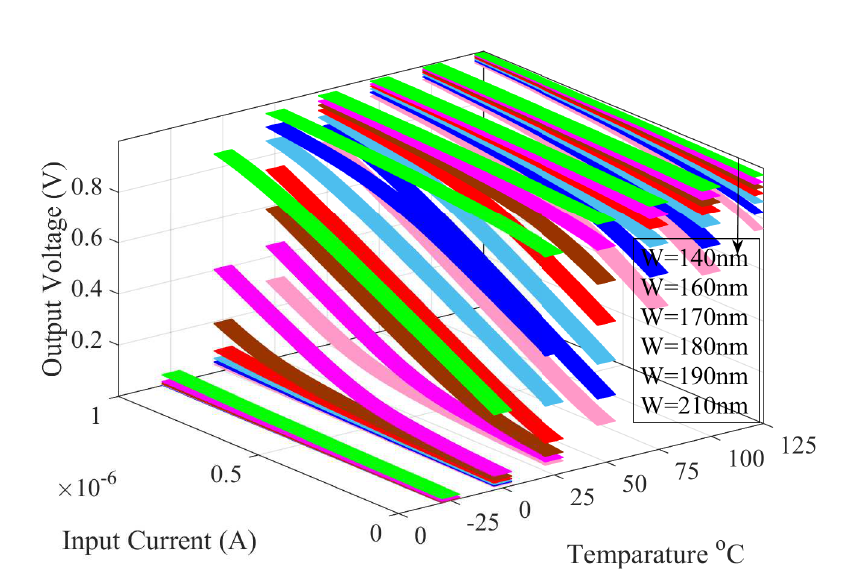
Figure 7. Tuning of the sensor circuit using the M5 transistor.